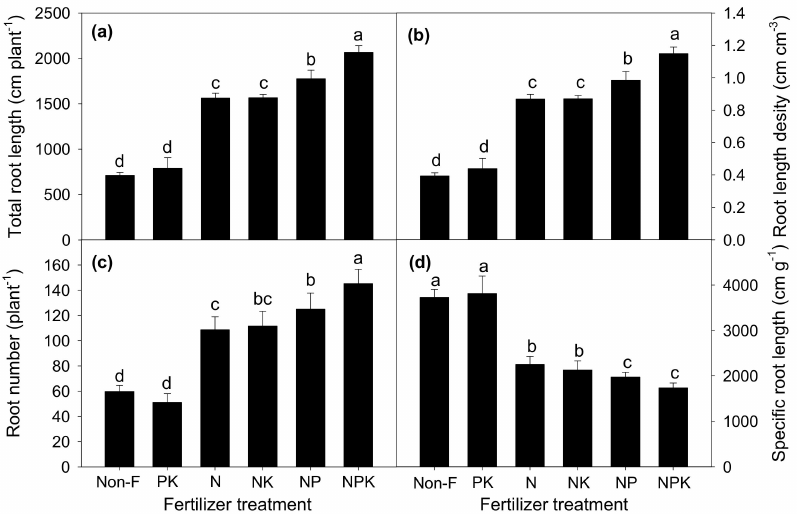
Figure 4. Destructively measured the total root length ( a ), root length density ( b ), root number ( c ), and specific root length ( d ) of per plant at 42 d after transplanting. Vertical bars indicate ± SE ( n = 3). The lowercase letters indicate the statistical difference between treatments ( p < 0.05).